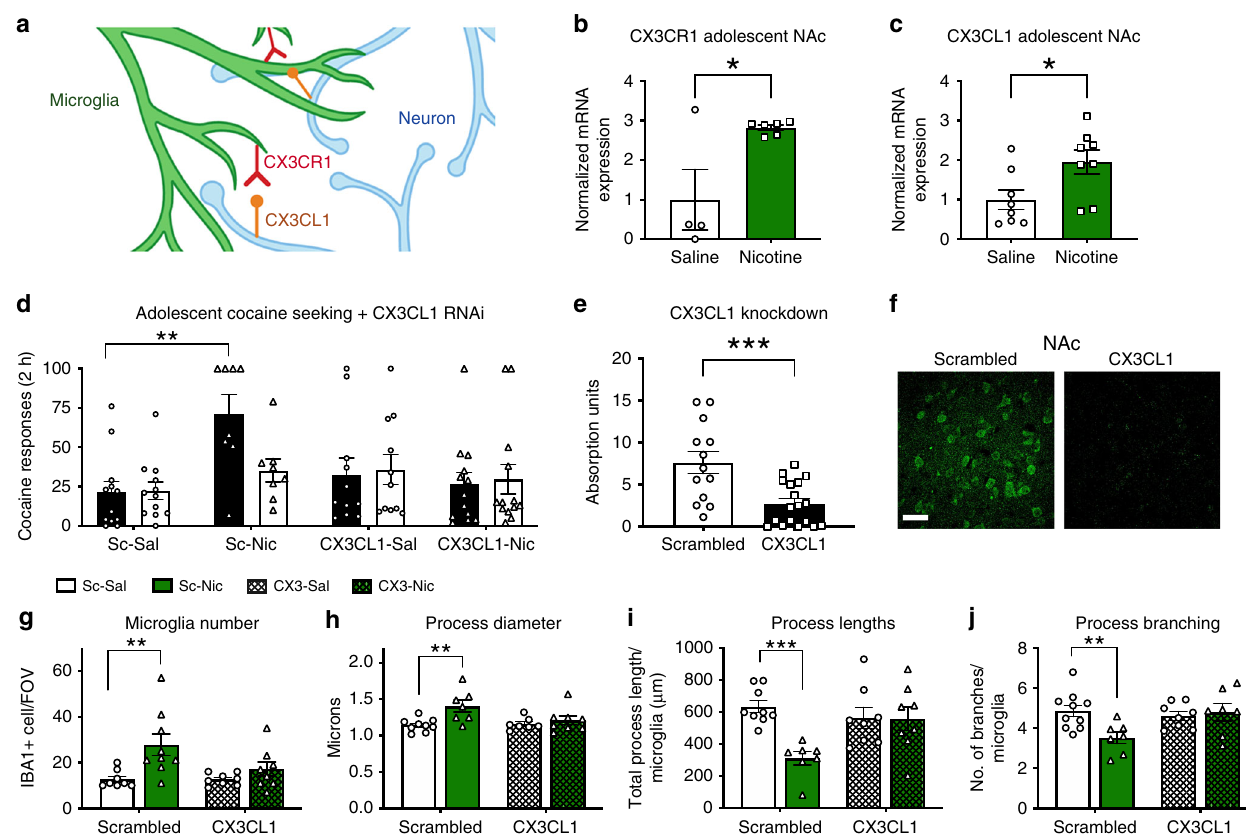
Fig. 6 Nicotine mediates increases in cocaine self-administration and microglial activation through the CX3CL1 receptor. a Schematic of the microglial CX3CR1 interactions with the neuronal CX3CL1. b Nicotine signi fi cantly increases CX3CR1 mRNA ( t 8 = 2.984, * p = 0.0175, r 2 = 0.5267) ( n = 4 saline, n = 5 nicotine). c Nicotine signi fi cantly increases CX3CL1 mRNA ( t 14 = 2.455, * p = 0.0278, r 2 = 0.3010) ( nn = 8). d RNAi of CX3CL1 blocked nicotine induced increases in cocaine seeking. We observed a signi fi cant interaction between response and CX3CL1 ( F (1, 41) = 5.450; p = 0.0246, η 2 = 2.216), response and nicotine ( F (1, 41) = 6.411), p = 0.0153, η 2 = 2.606), CX3CL1 and nicotine ( F (1, 41) = 4.530, p = 0.0394, η 2 = 7.307), and response, CX3CL1 and nicotine ( F (1, 41) = 4.347, p = 0.0433, η 2 = 1.767) ( n = 12 scrambled-saline, 8 scrambled-nicotine, 11 CX3CL1-saline, 13 CX3CL1-nicotine). e Knockdown veri fi cation of CX3CL1 ( t 29 = 3.712; p = 0.0009) ( n = 13 scrambled, 18 CX3CL1). f Example images of CX3CL1 staining with a scrambled and CX3CL1 targeted oligo. g Nicotine increases microglia number in a CX3CL1-dependent manner ( F (1, 29) = 10.02, p = 0.0036, η 2 = 21.87) ( n = 8). h Nicotine- induced increases in microglial process diameter are dependent on CX3CL1 ( F (1, 27) = 8.578, p = 0.0068, η 2 = 20.59) ( n = 9 scrambled-saline, 7 scrambled-nicotine, 7 CX3CL1-saline, 8 CX3CL1-nicotine). i Nicotine increased microglial process lengths, and this was blocked with the CX3CL1 targeted oligo. A signi fi cant effect of nicotine ( F (1, 28) = 8.377, p = 0.0073, η 2 = 18.37) and interaction between RNAi and nicotine treatment ( F (1, 28) = 7.815, p = 0.0093, η 2 = 17.14) ( n = 9 scrambled-saline, 7 scrambled-nicotine, 7 CX3CL1-saline, 8 CX3CL1-nicotine). j CXC3CL1 knockdown blocked nicotine-induced changes to microglial process branching with a signi fi cant interaction between nicotine and RNAi ( F (1, 28) = 5.650, p = 0.0245, η 2 = 14.46) ( n = 10 scrambled-saline, 7 scrambled-nicotine, 8 CX3CL1-saline, 8 CX3CL1-nicotine). Behavioral data analyzed with a three-way ANOVA, morphology data was analyzed with a two-way ANOVA, and mRNA analyzed with a t -test. All ANOVAs further analyzed with a Bonferroni post hoc tests (* p < 0.05, ** p < 0.01, *** p < 0.001, **** p < 0.0001). Scale bar 50 μ m. Bars show mean + / – s.e.m. Source data is available as a Source Data fi